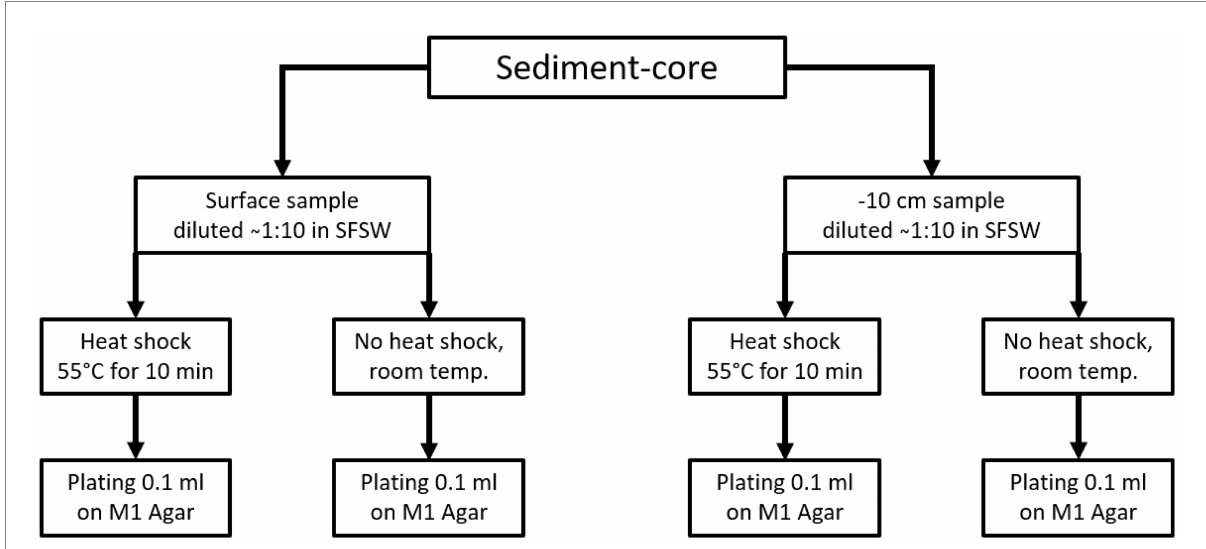
FIGURE 1 Sample process and plating scheme for the sediment samples. From each sediment core one surface sample and one sample from-10 cm under surface. Each sample was processed once using the heat-shock pre-treatment and once without heat shock. All sediment samples were plated on M1 isolation agar, the same scheme was applied for the sediments retrieved from Bjørnøya.